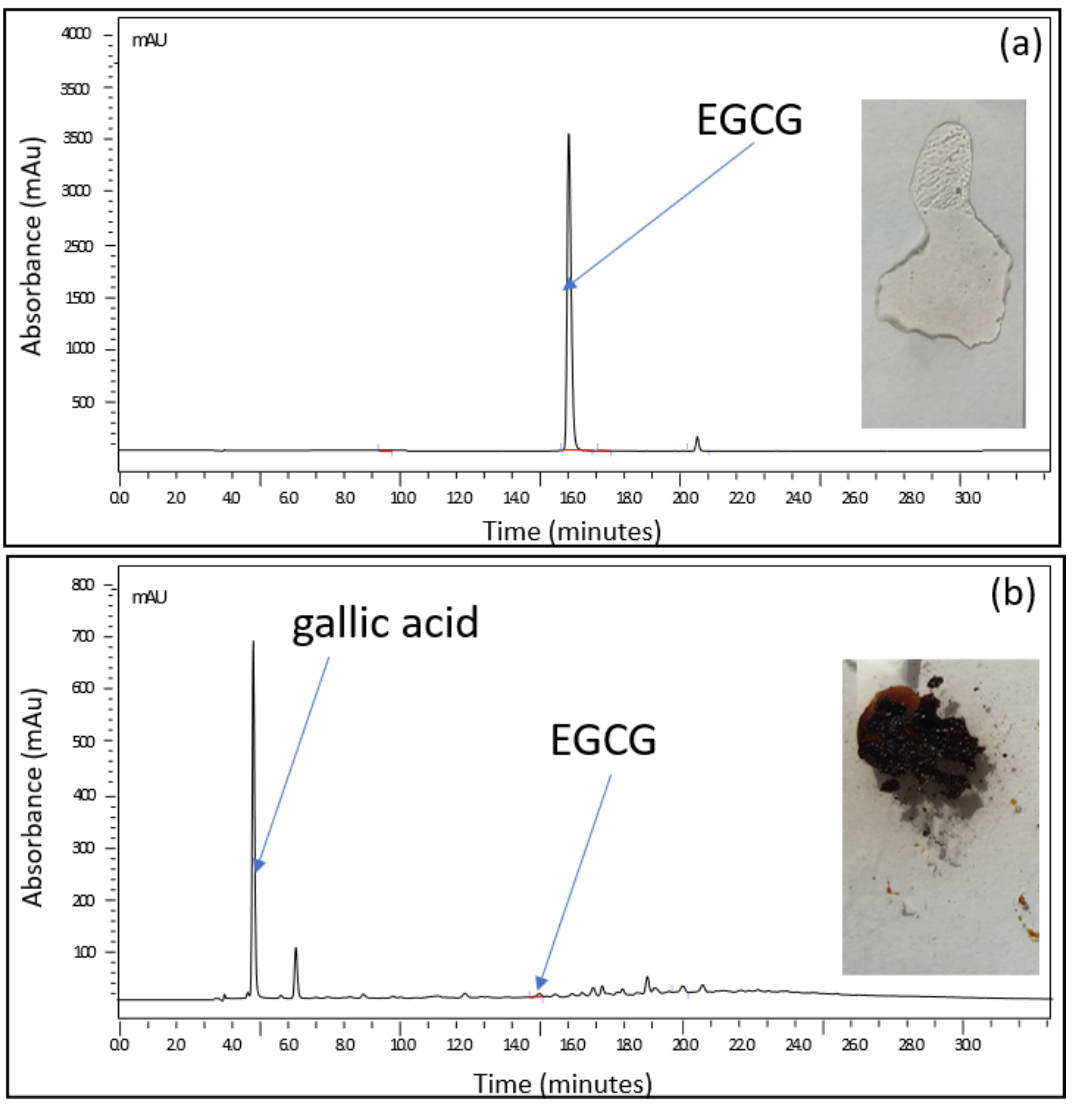
Figure 1. Stability of EGCG versus that of equimolar EGCG/sucrose; 1 mL of ( a ) an equimolar EGCG/sucrose solution (EGCG = 25 mg·mL − 1 ; sucrose = 19 mg·mL − 1 ) and ( b ) an EGCG-based solution alone (25 mg·mL − 1 ) subjected to a thermal gradient program ranging from 25 to 115 °C at a rate of 5 °C per min. At the end of this exposure, part of each of the residues formed was deposited on a glass slide and the remaining part was analyzed using high-performance liquid chromatography.